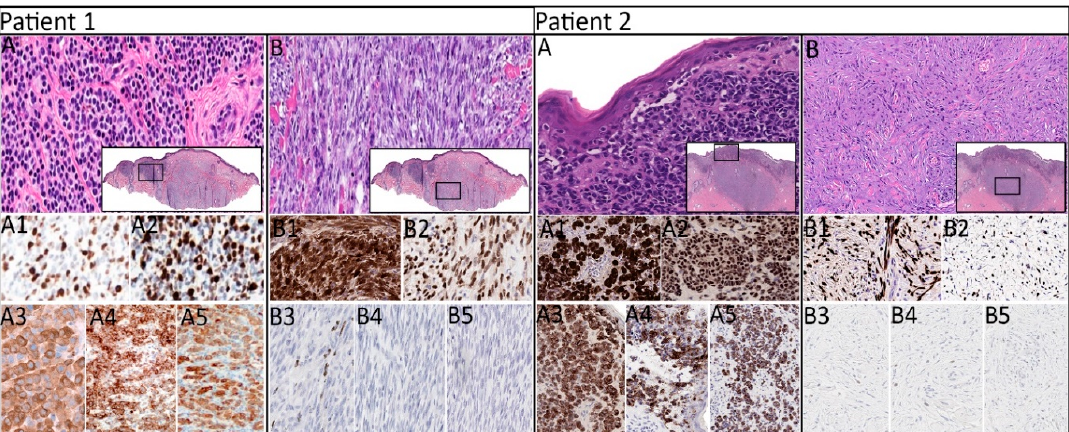
Figure 1. Histomorphologic and immunophenotypic of primary melanomas in patients 1 and 2. Patient 1: primary cutaneous melanoma with nevoid ( A ) and spindled ( B ) regions (H&E, × 400; insets, × 20) exhibiting di ff use expression of S100 ( A1 ), SOX10 ( A2 ), pan-melanocytic cocktail ( A3 ), HMB-45 antigen ( A4 ), and Melan-A ( A5 ) in the nevoid region and di ff use expression of S100 ( B1 ) and SOX10 ( B2 ), scattered focal expression of pan-melanocytic cocktail ( B3 ), and negative expression of HMB-45 antigen ( B4 ) and MelanA ( B5 ) in the spindled region (IHC, × 200). Patient 2: primary cutaneous melanoma with superficial epithelioid ( A ) and deep spindled ( B ) regions (H&E, × 400; insets, × 20) exhibiting di ff use expression of S100 ( A1 ), SOX10 ( A2 ), and pan-melanocytic cocktail ( A3 ) and patchy expression of HMB-45 antigen ( A4 ) and Melan-A ( A5 ) in the epithelioid region and diffuse expression of S100 ( B1 ) and SOX10 ( B2 ) and negative expression of pan-melanocytic cocktail ( B3 ), HMB-45 antigen ( B4 ), and Melan-A ( B5 ) in the spindled region (IHC, ×200). H&E, hematoxylin and eosin; IHC, immunohistochemistry.